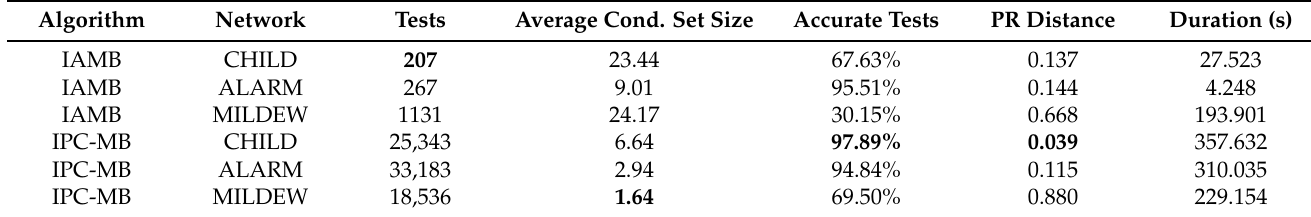
Table 4. G-test results across all datasets of 8000 samples for IAMB and